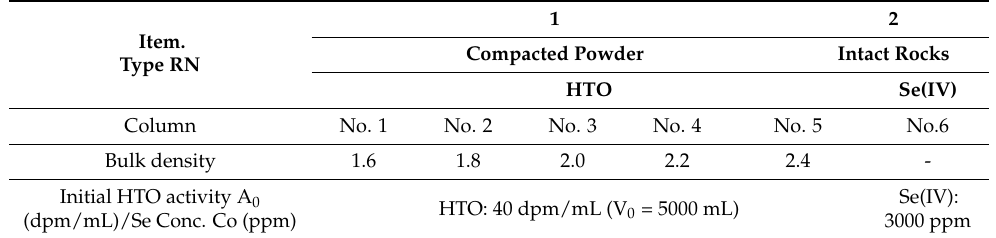
Table 1. The through-diffusion conditions for the HTO and Se(IV) in compacted and intact clay rocks. Item. Type RN